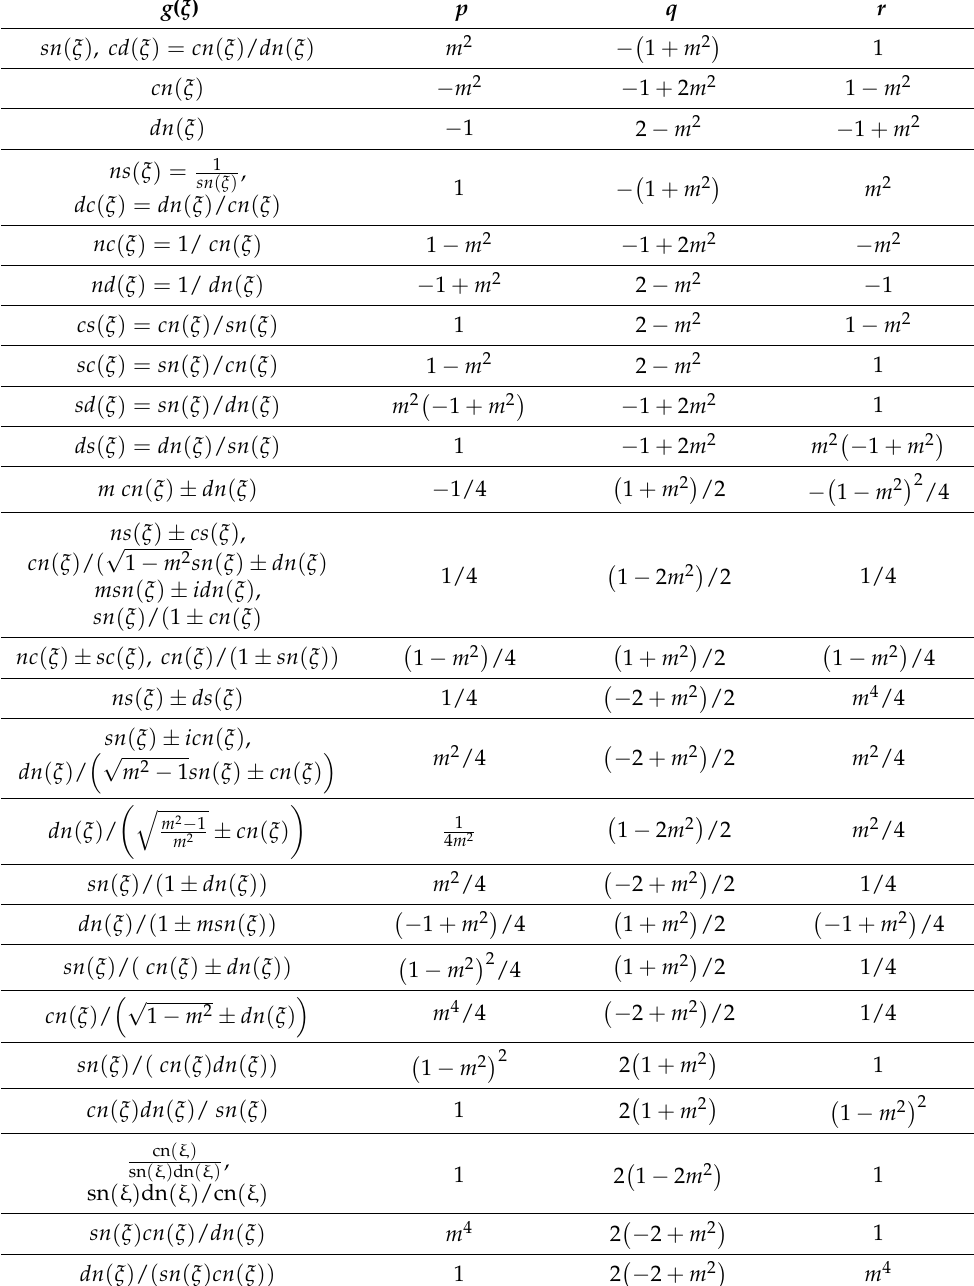
Table 1. The mapping of the Jacobi elliptic function solutions for Equation